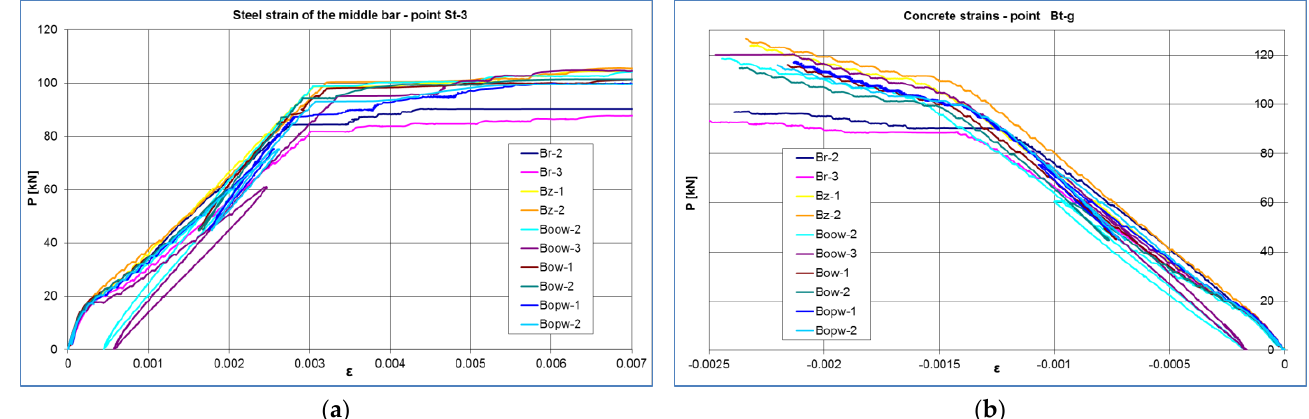
Figure 8. ( a ) Strains of middle reinforcing bar measured in the cross-section at the center of beam span (point St-3 according to Figure 3). ( b ) Concrete strains measured on the top surface at the cross-section at the center of beam span (mean value of strains measured in points Bt-3 and Bt-4 according to Figure 3).